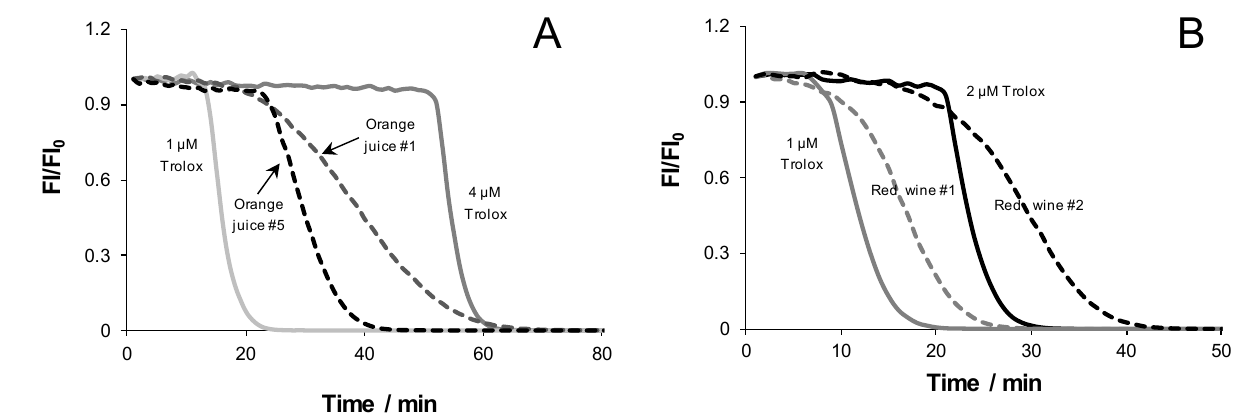
Figure 3. ORAC curves obtained for the standard antioxidant Trolox (full lines), juice samples ( A , dashed lines) and wine samples ( B , dashed lines).